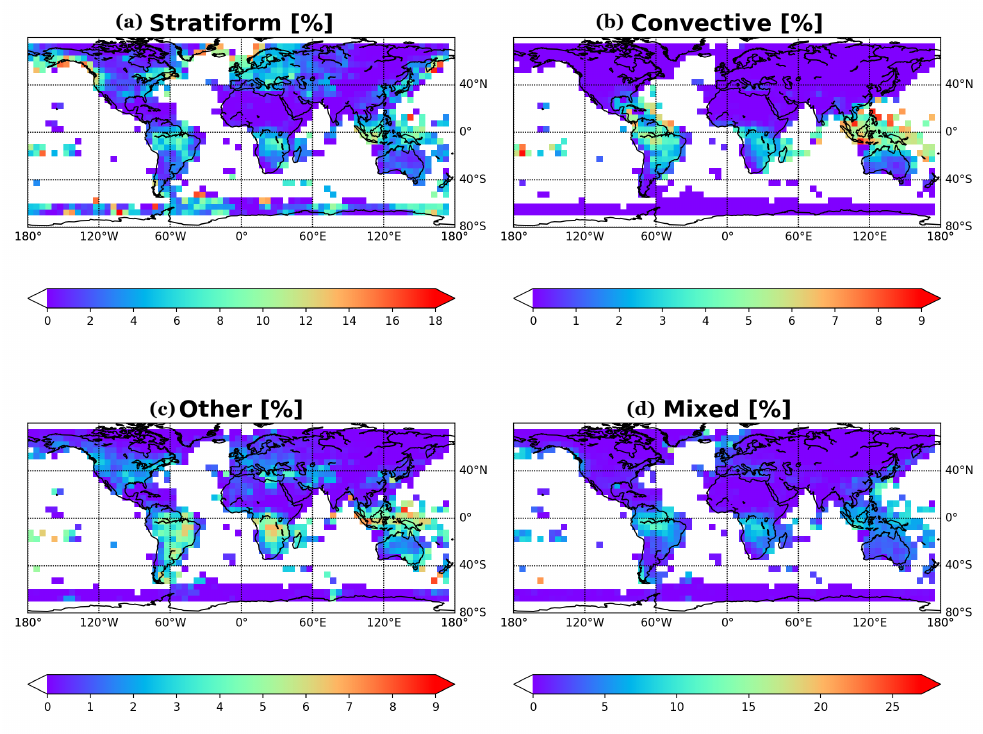
Figure 10. Geographic distribution of precipitation type occurring frequency (%) over land and sea ice during January, February and December of 2017 from CNN model predictions using full-swath GMI’s L1-CR data for ( a ) stratiform, ( b ) convective, ( c ) other, and ( d ) mixed. Color bars correspond to the occurring frequency in the unit of